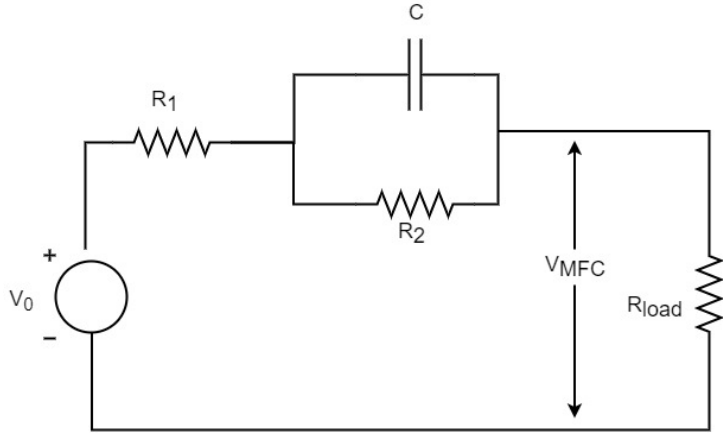
Figure 5. MFC modeling using an Equivalent Electrical Circuit